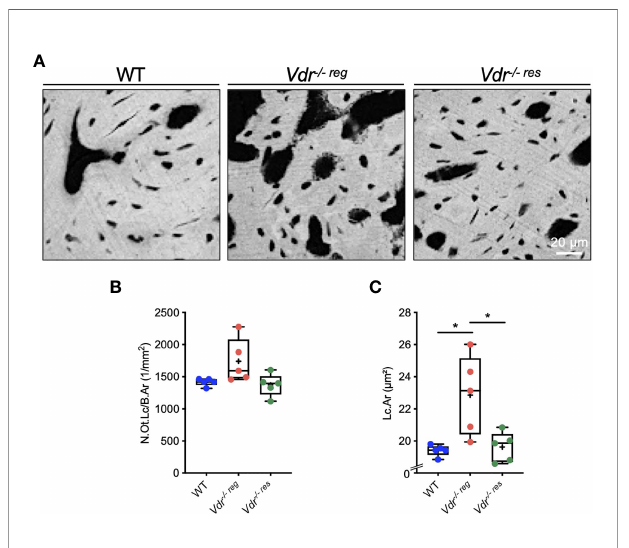
FIGURE 4 | Osteocyte lacunar characteristics of the malleus analyzed by qBEI. (A) Representative qBEI images showing osteocyte lacunae in the malleus of WT, Vdr -/- reg and Vdr -/- res mice. (B) Quanti fi cation of the osteocyte lacunar number (N.Ot.Lc/B.Ar) and (C) mean osteocyte lacunar area (Lc.Ar). ANOVA and repeated measures with Holm-Sidak correction was performed in panels (B) and (C) *p<0.05.